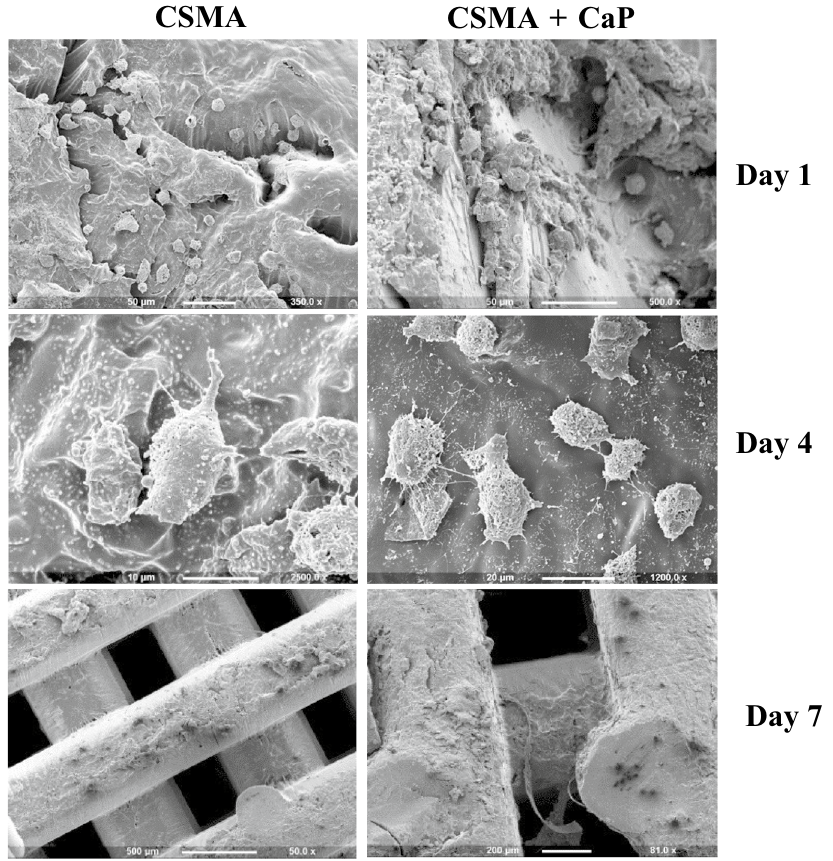
Figure 6. Observation of MC3T3 proliferation on the surface of DLP printed CSMA and CSMA + CaP at 1-, 4- and 7-days post-seeding: the cells exhibit optimum spreading over the incubation period with preference in attachment towards the edges of the samples. Abundant growth of the cells throughout the printed surface can be spotted as early as day 4, where a monolayer of cells is formed. A confluent single cell layer filling the entire surface area is reached at the final time point (day